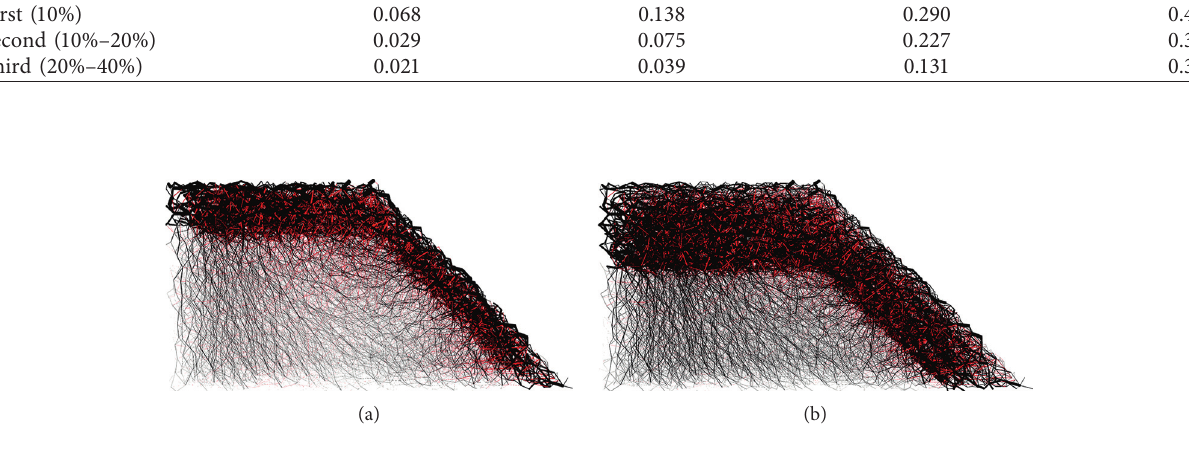
Figure 13: Side contact force chains at different frozen depths. (a) 20% and (b) 40%. Table 5: Ratio of tension to